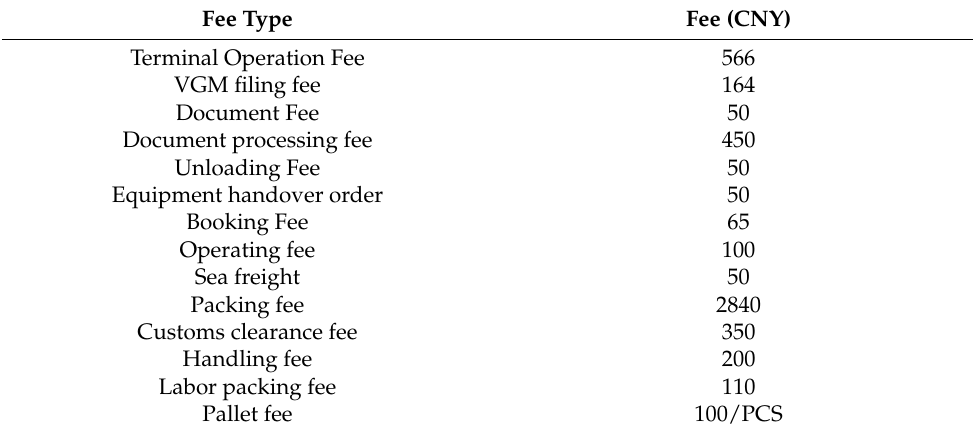
Table 8. Port miscellaneous charges at Dalian